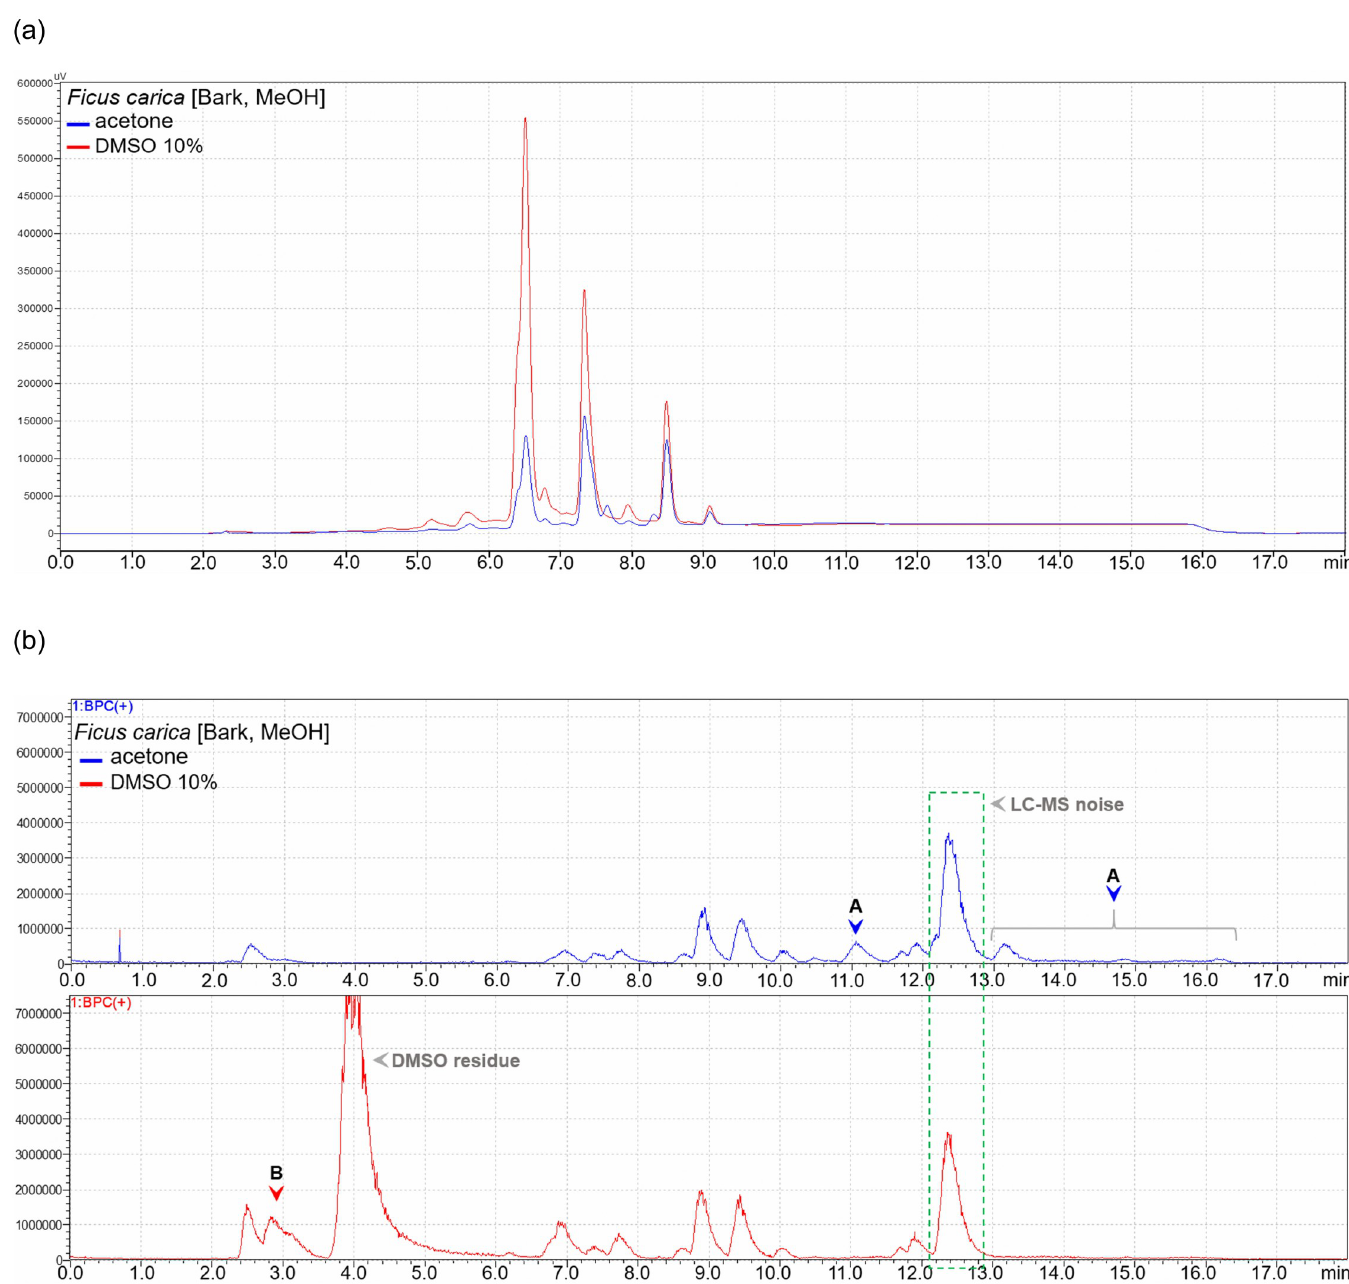
Fig 3. a . An overlay of UV chromatograms of acetone (blue) and DMSO (red) based working solutions of a methanol barks extract of F . carica , which had a better solubility in 10% DMSO. Higher quantities of phytochemicals are seen in the in a DMSO based working solution. b . Comparison of base peak chromatograms of acetone (blue) and DMSO (red) based working solutions of a methanol barks extract of F . carica , which had a better solubility in 10% DMSO. At least 4 (marked A) and 1 (marked B) additional compound(s) are visible in the chromatograms of acetone and DMSO based working solutions,